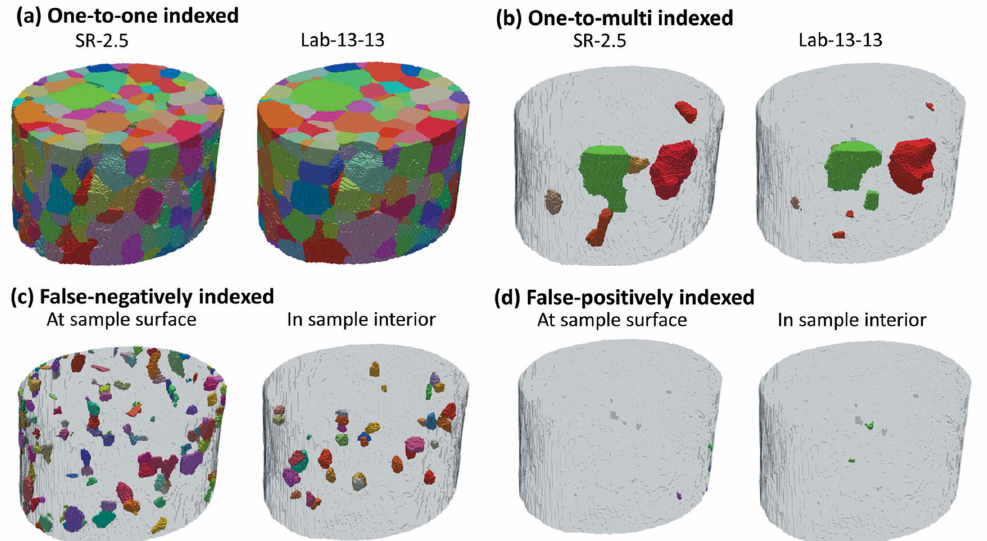
Figure 3 Visualization of the correspondence between indexed grains in the SR-2.5 and Lab-13-13 datasets. ( a ) One-to-one indexed grains, ( b ) one-to-multi indexed grains, ( c ) false-negatively indexed grains seen in the SR-2.5 dataset (but not in the Lab-13-13 dataset) that are at the sample surface or located in the sample interior and ( d ) false-positively indexed grains seen in the Lab-13-13 dataset that are at the sample surface or located in the sample